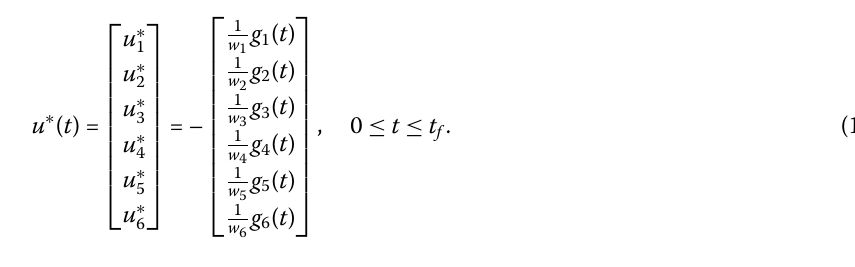
Considering t f = 5, w i = v i = 1, the parameter values as in Table 1, and the initial conditions f 0 = (0.01,0.01,0.01,0.01,0.01,0.01), we solve the aforesaid BVP numerically [45, 46]. In Fig. 5, the state trajectories of the considered system in the absence and the presence of control are compared. It is obvious that the state variables converge and stay near the